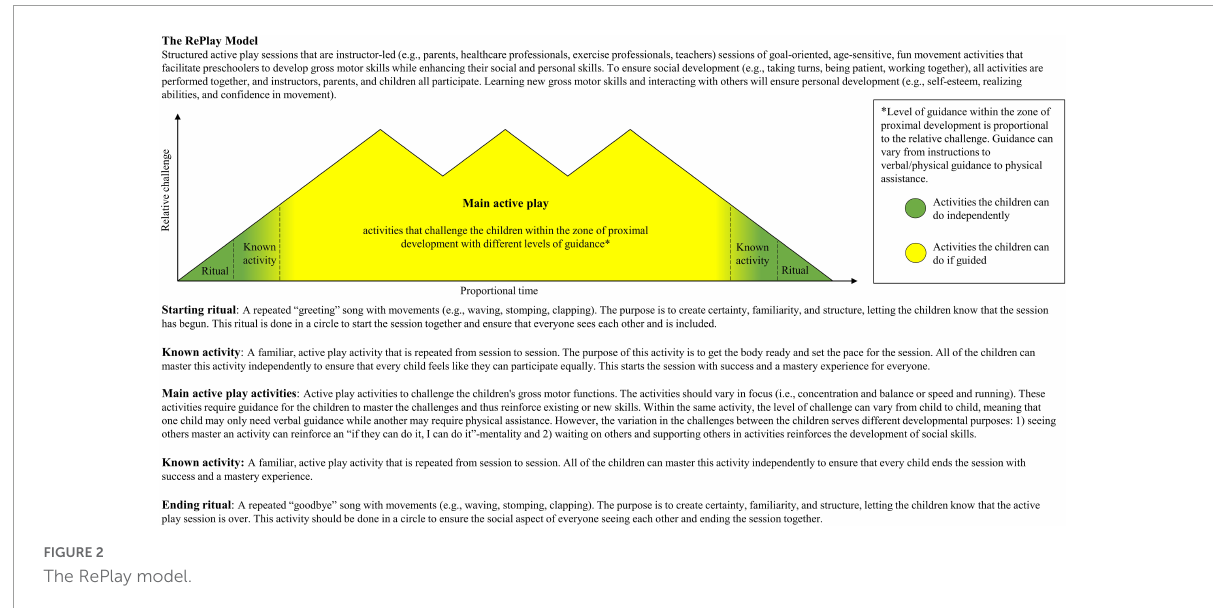
FIGURE2 The RePlay